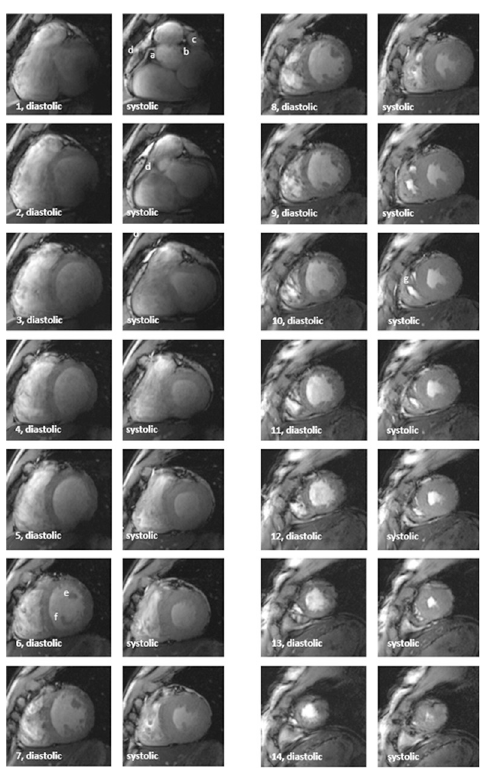
Fig 2. Example of a short axis stack covering the ventricles from the basal slice (image pair 1) to the apical slice (image pair 14). The image quality was rated with 6 (artifact burden 2, noise 2, overall quality 2) in each segment with the exception of segments 4 and 5 (left ventricular basal inferolateral wall), here the overall quality was less and the score rated as 7. All slices were obtained with ACT triggering. Each of the slices is represented pairwise as diastolic and systolic. The right ventricular morphology is detectable throughout all slices, whereas in comparison the basal lateral segments of the left ventricle show a lower contrast. a) proximal segment of the right coronary artery. b) proximal segment of the left main coronary artery. c) left atrial appendaged) right atrial appendage. e) anterolateral papillary muscle. f) posterior papillary muscle. g) moderator band.